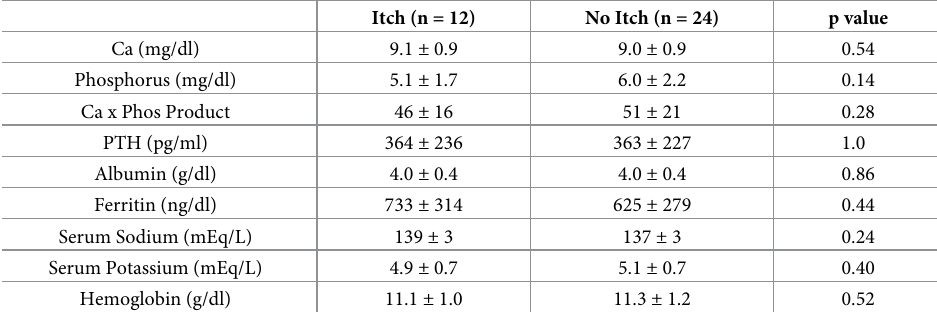
Table 2. Laboratory data of Itch and No Itch HD